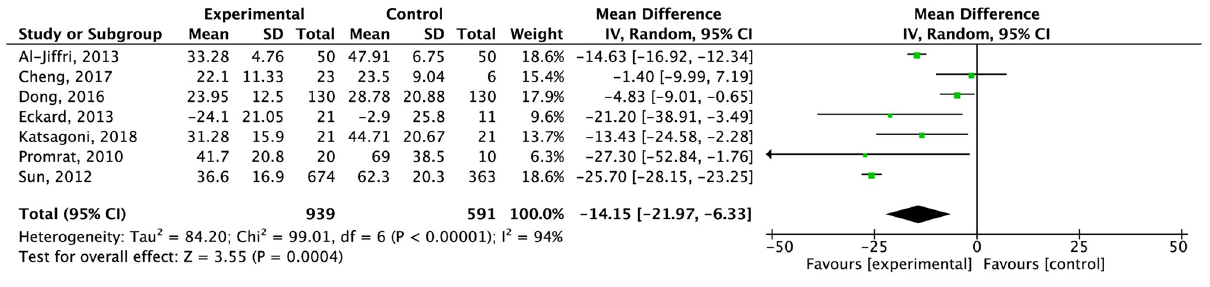
Fig 7. Effect of exercise plus diet compared to the control group in ALT concentration.